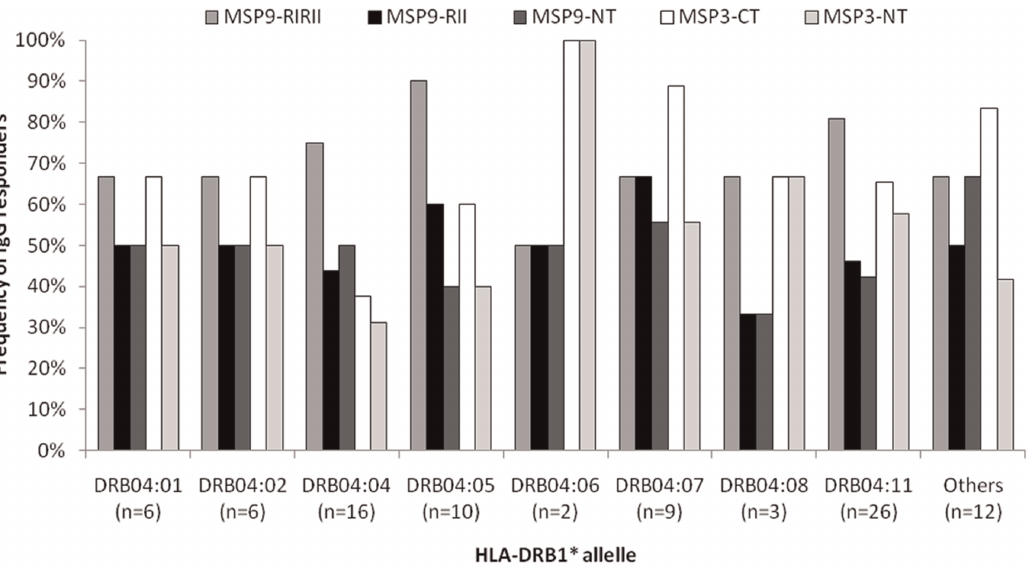
Figure 3. Frequency (%) of responders to PvMSP9 and PvMSP-3 recombinant proteins by HLA-DRB1*04 alleles. The frequencies of responders were not associated to a particular HLA-DRB1*04 allelic group by the bipartition x 2 test (p . 0.05). * ‘‘Others’’ category groups individuals with HLA-DRB1*04 less frequent alleles.